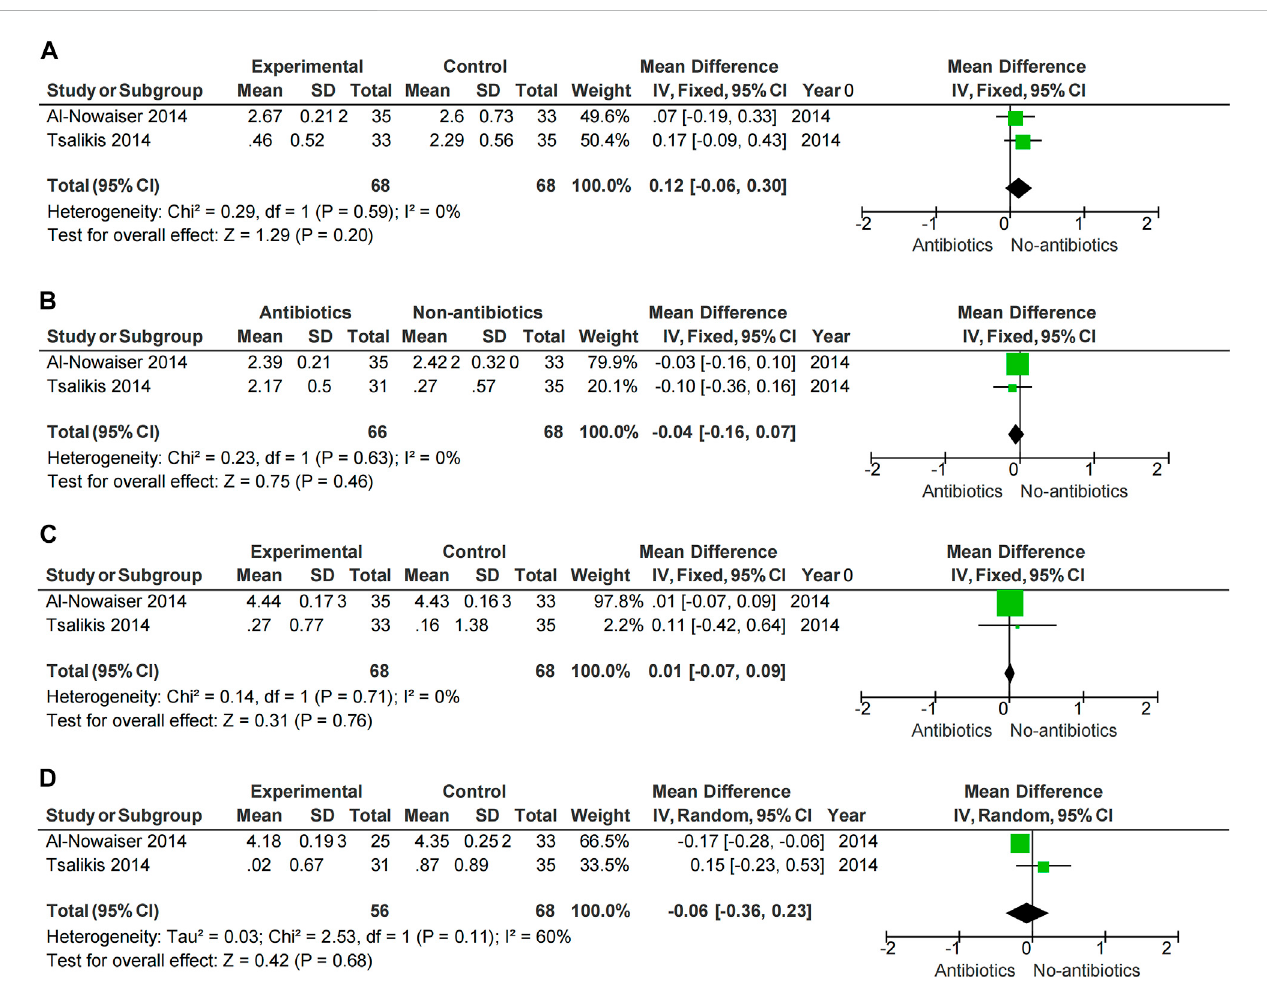
FIGURE 6 Forest plot of the effect of Doxycycline on periodontal changes. (A – B) Changes in PD at 3 and 6 months. (C – D) Changes in CAL at 3 and 6 months.